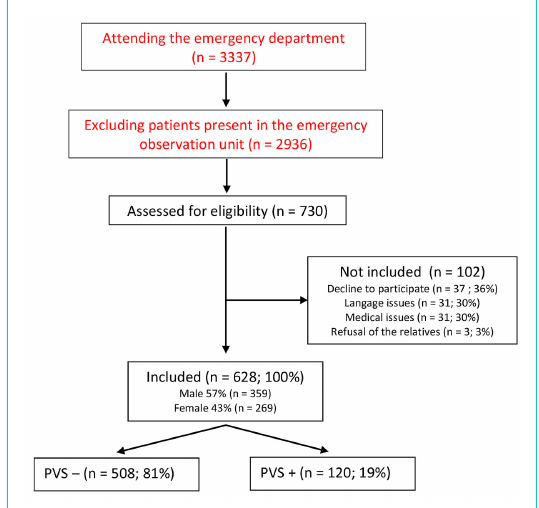
Figure 1: Patient recruitment flowchart.PVS = Partner Violence Screening questionnaire